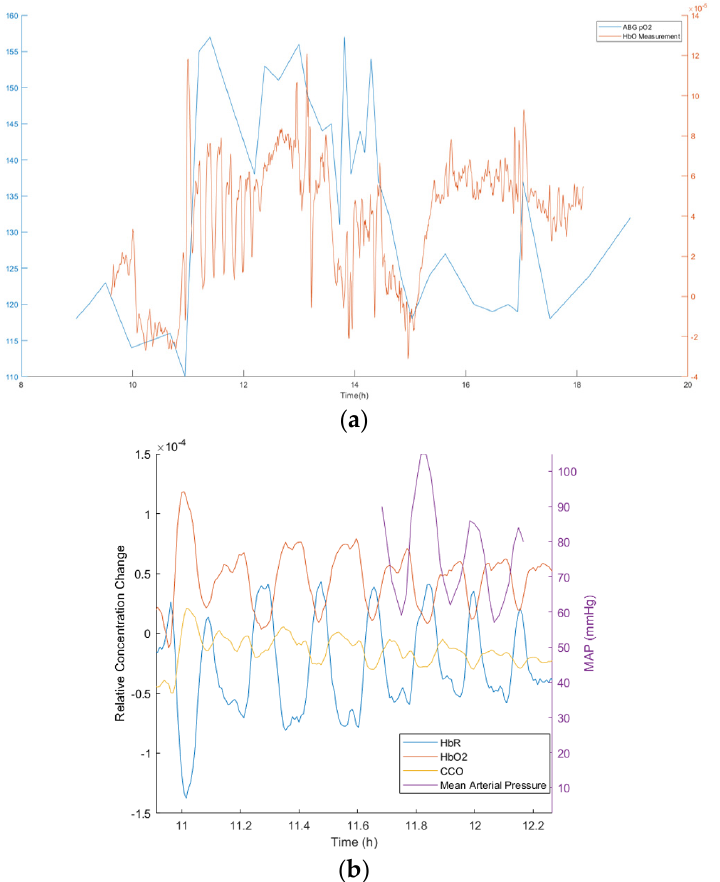
Figure 35. ( a ) SCISCCO measure of HbO (red) and oxygenation measured with arterial blood gas (ABG) instrument (blue). ( b ) HbO, HbR, and CCO measured with SCISCCO and arterial pressure from an independent instrument (purple).